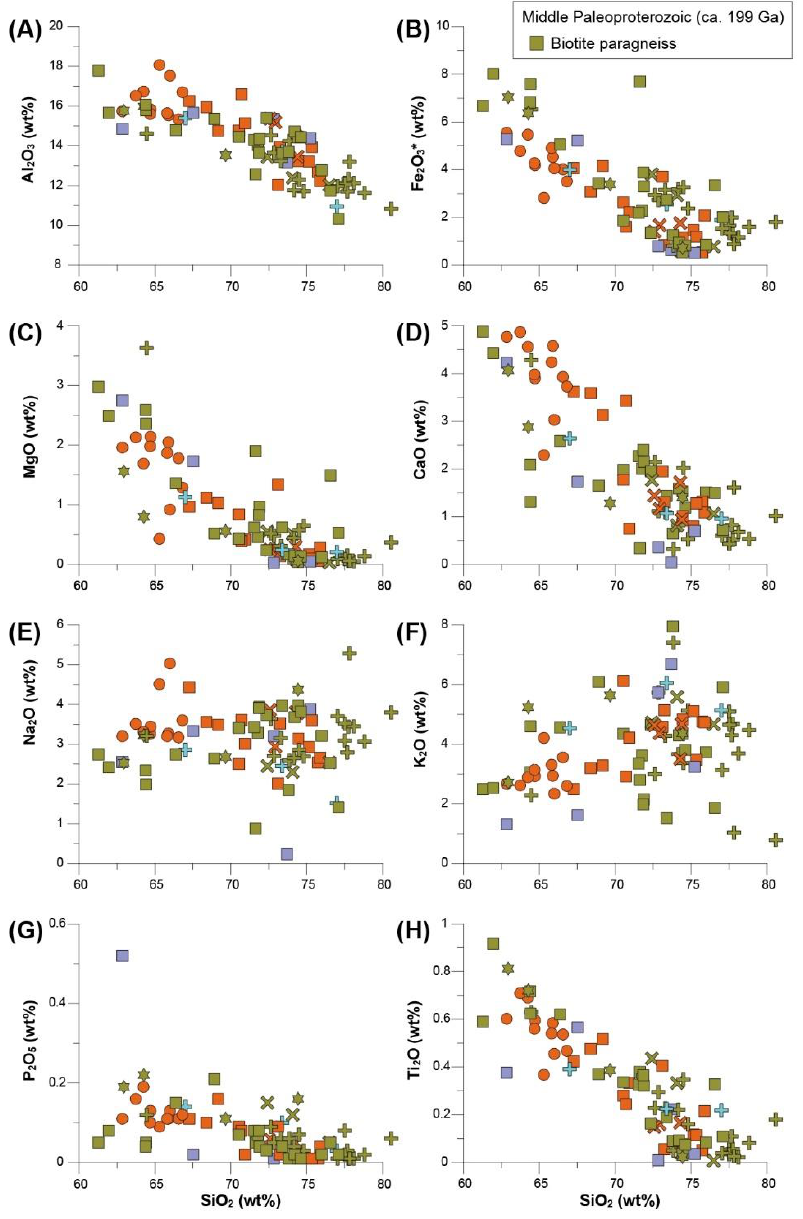
Figure 7. Plots of major elements ( A ) Al 2 O 3 , ( B) Fe 2 O 3 *, ( C ) MgO, ( D ) CaO, ( E ) Na 2 O, ( F ) K 2 O, ( G ) P 2 O 5 , and ( H ) TiO 2 versus SiO 2 for the Middle Paleoproterozoic gneisses, Late Triassic granite, and Early Jurassic granitic rocks in the Jangsu-gun area. Symbols are as in Figure 6.